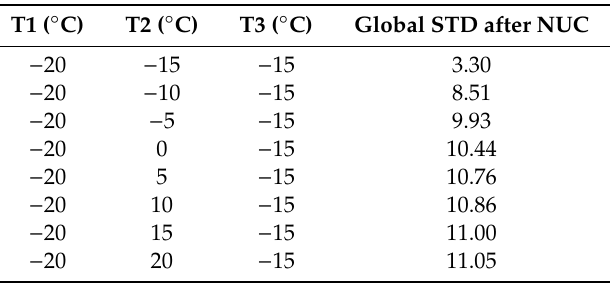
Table 3. TP NUC statistics of experiment 2.